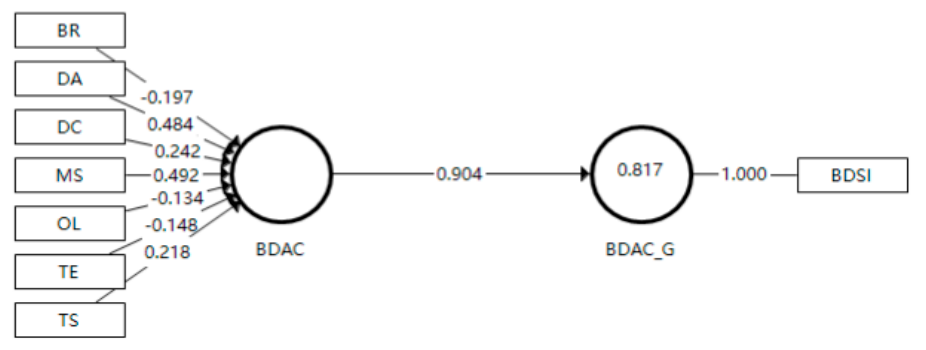
Figure 2. Results of redundancy analysis.